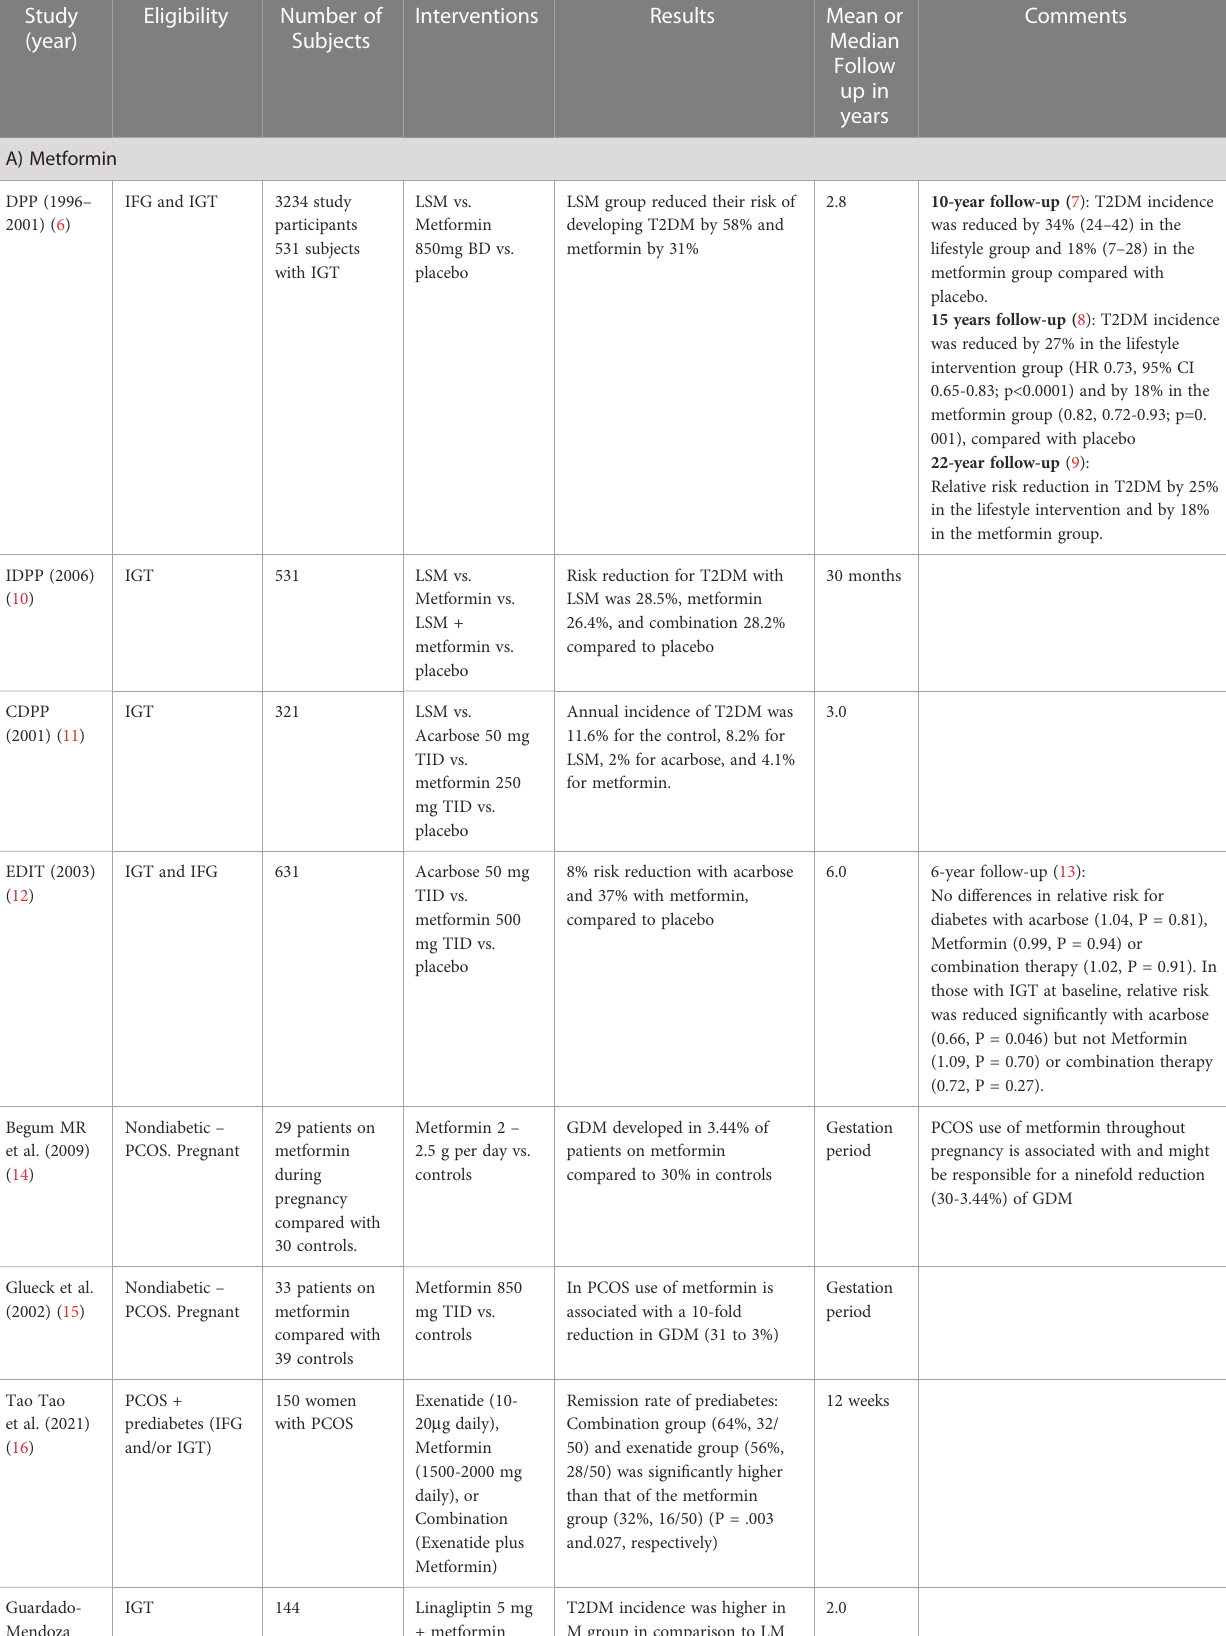
TABLE 1 Summary of clinical trials on T2DM prevention with glucose lowering drugs and weight-loss